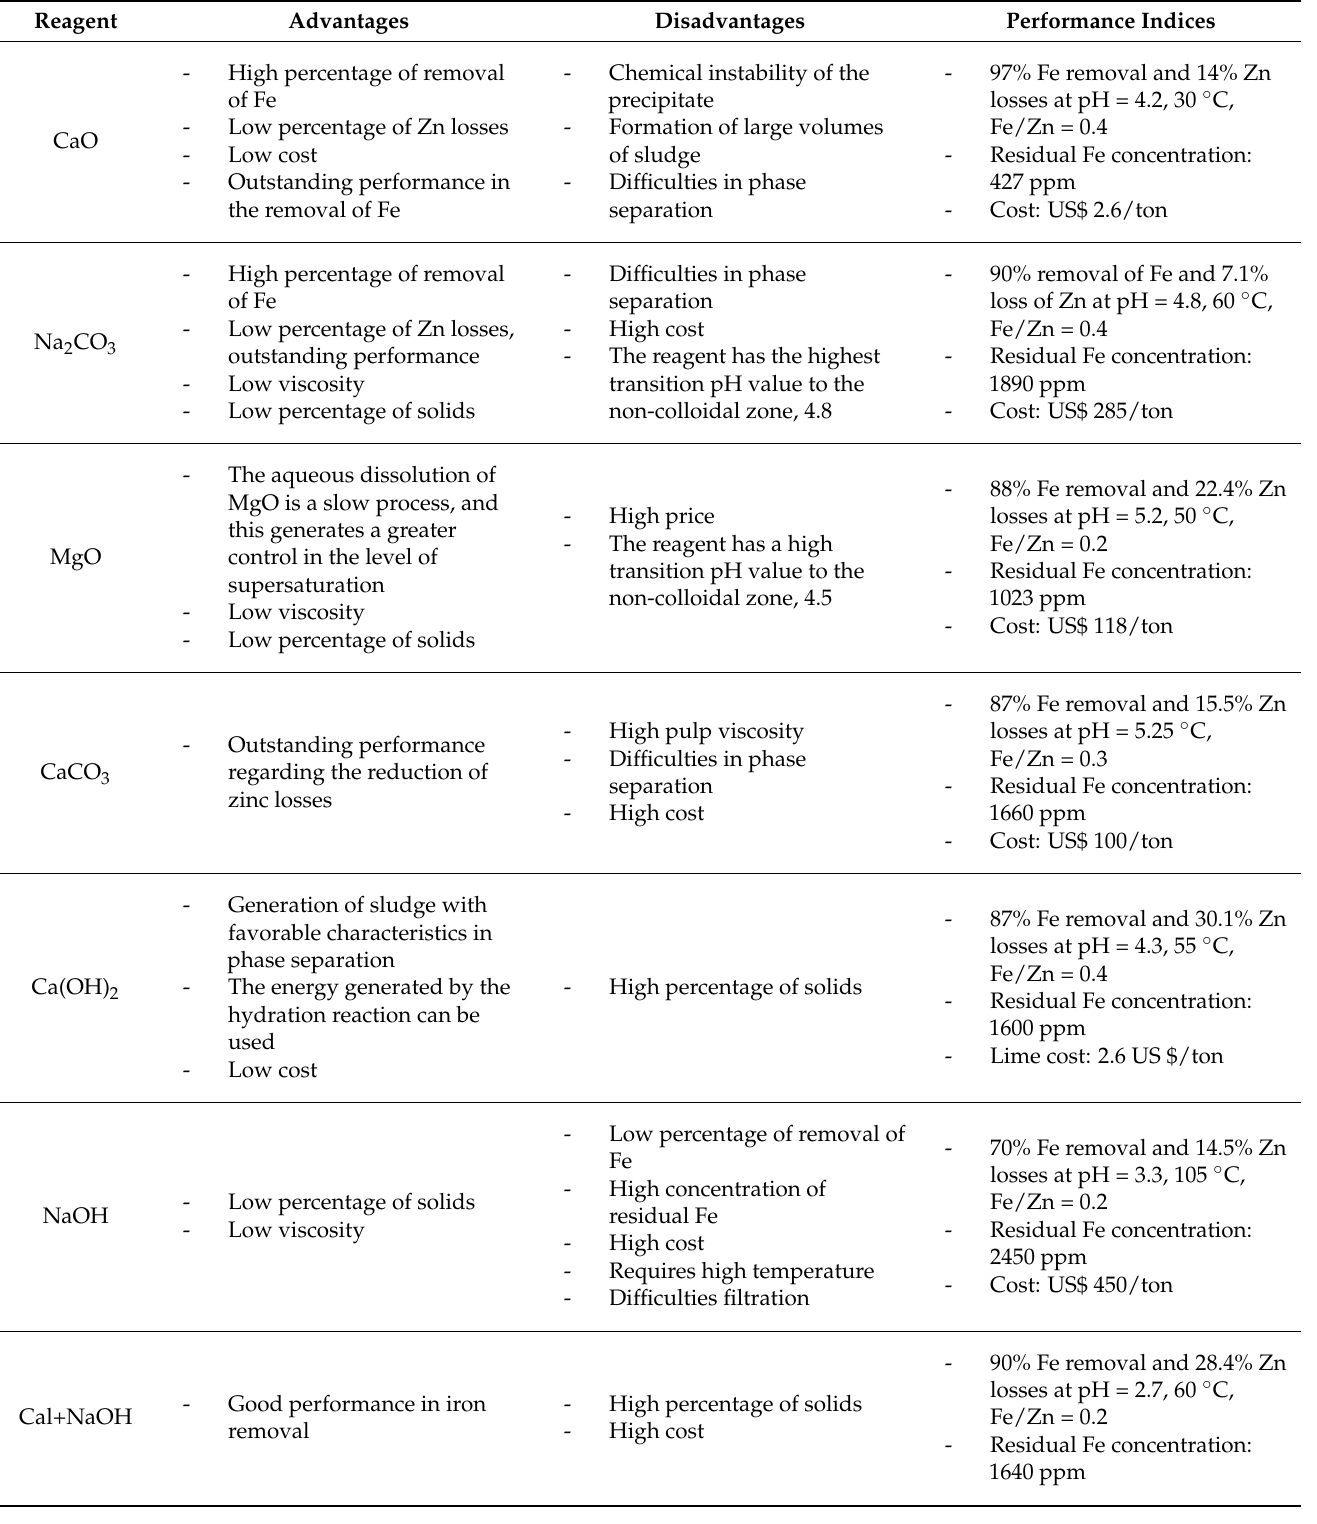
Table 4. Summary of exploratory tests